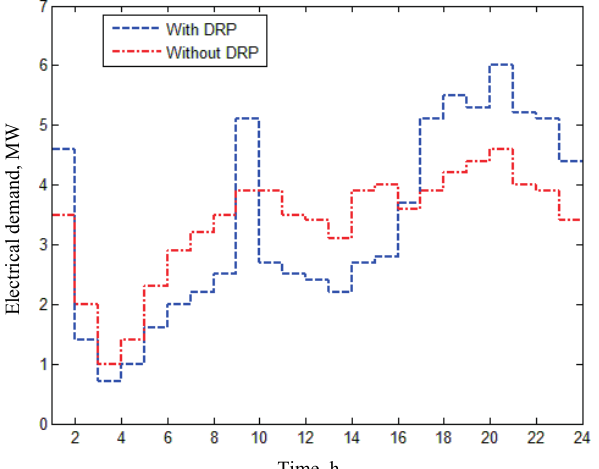
Fig. 5. Electrical load without and with